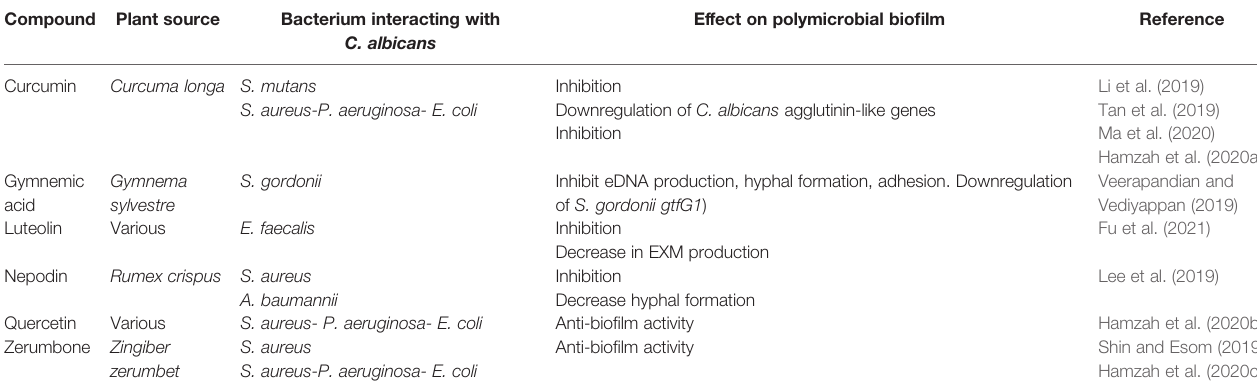
TABLE 4 | Plant-derived compounds with activity against polymicrobial bio fi